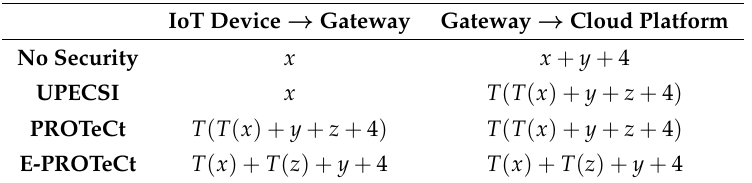
Table 3. Amount of data transmitted considering generated data of x bytes, an access token of y bytes and a hash of z bytes.